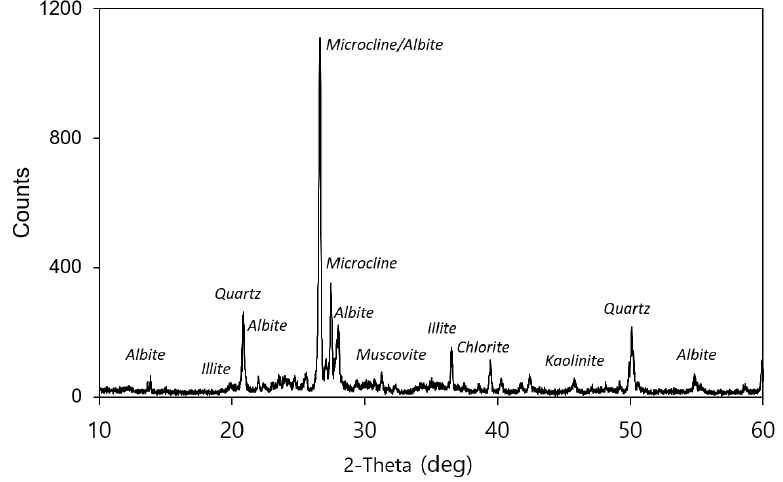
Figure 4. Representative mineralogical composition of soils from the shooting range determined using X-ray diffraction (XRD).